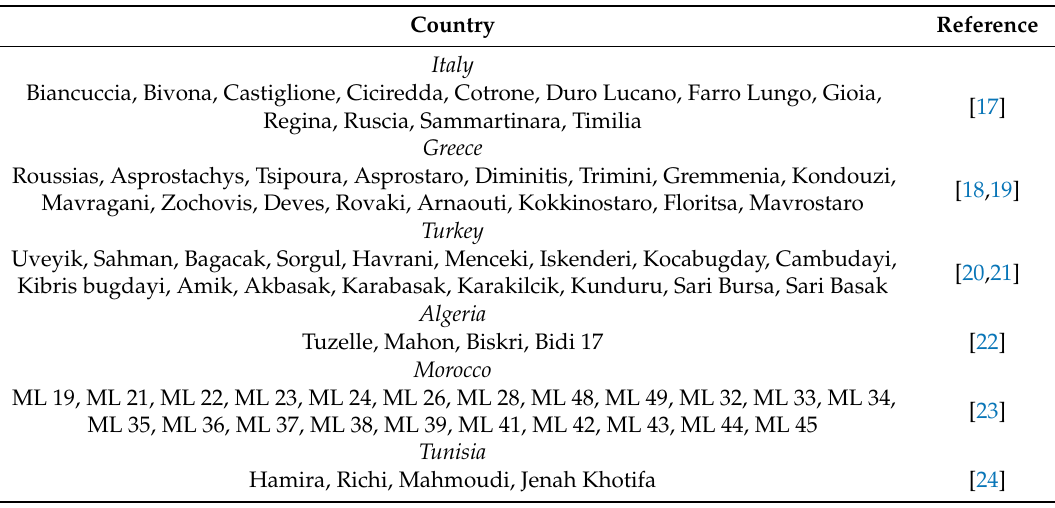
Table 2. The main Mediterranean wheat